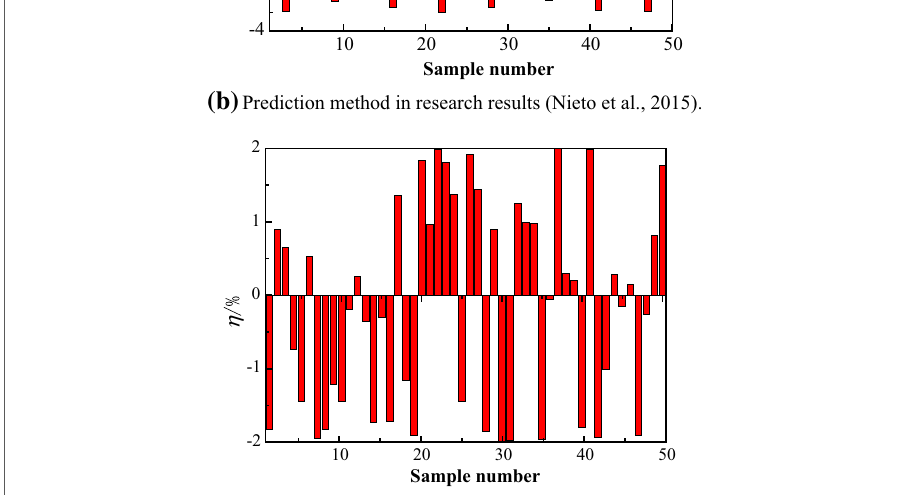
(a) Prediction method in research results (Yan et al., 2008).